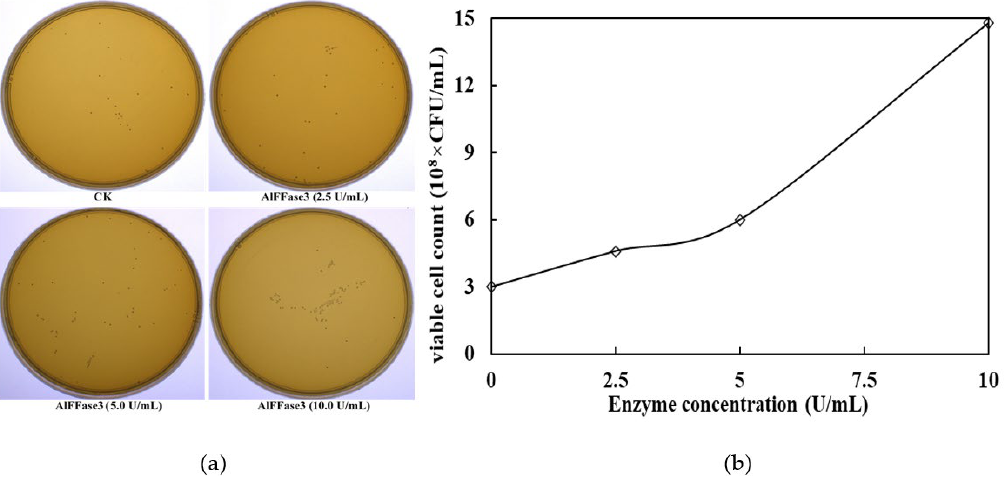
Figure 7. Effect of AlFFase3 on the proliferation of probiotics during yogurt fermentation process (( a ), colony growth images; ( b ), viable cell count results).